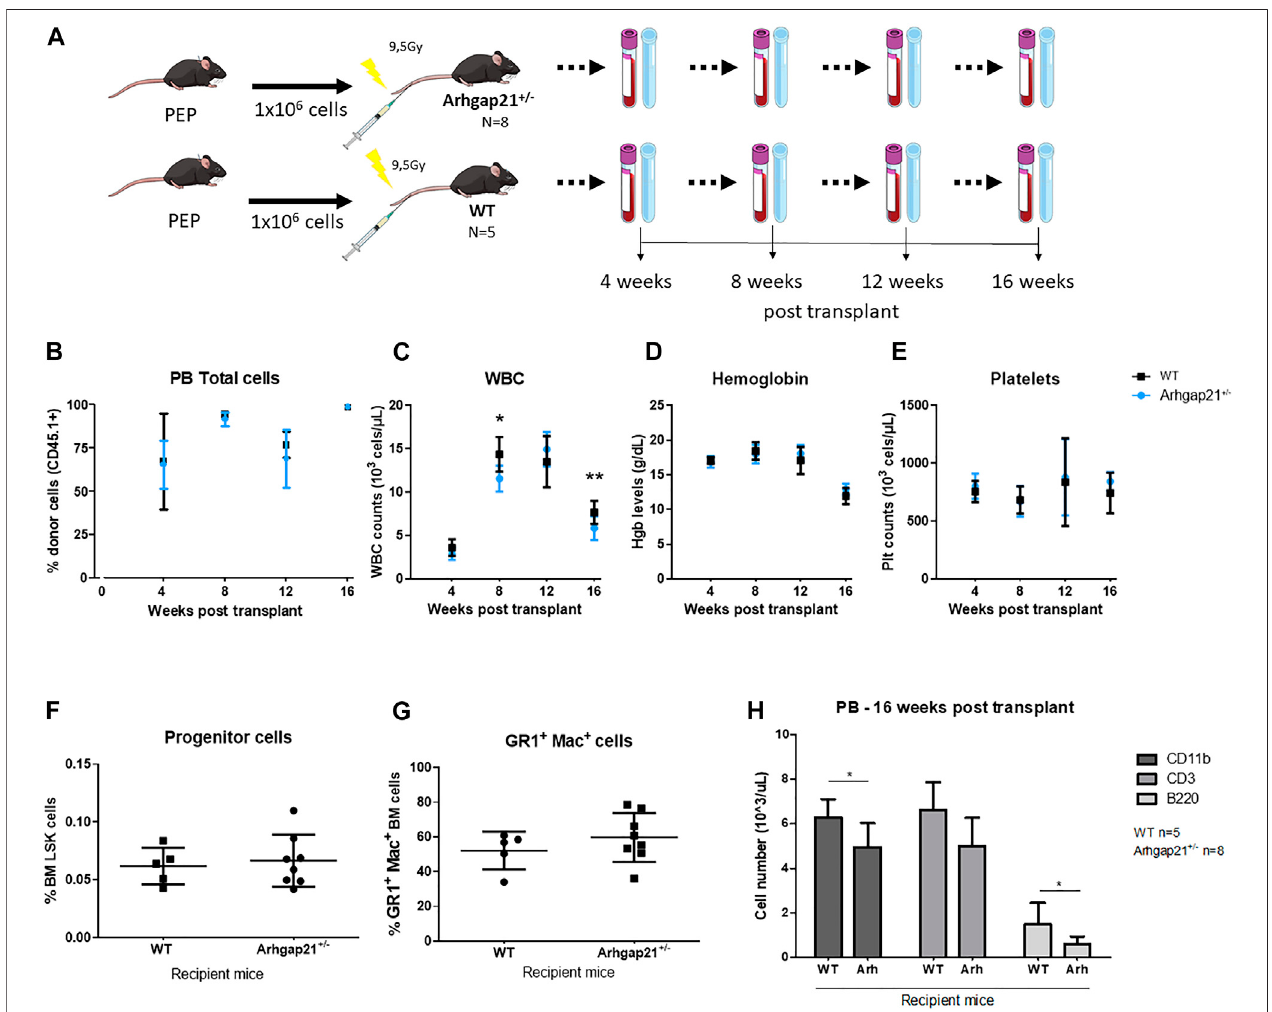
FIGURE 4 | Decreased WBC reconstitution in Arhgap21 +/ − recipients of bone marrow transplantation. (A) Schematic fi gure of 1 × 10 6 PEP BM cells transplanted into irradiated (9.5 Gy) Arhgap21 +/ − recipients ( N (cid:2) 8) and WT recipients ( N (cid:2) 5). Recipient mice were maintained for 16 weeks after transplantation and chimerism (CD45.1+), WBC count, hemoglobin levels (Hgb) and platelet count (Plt) were assessed every 4 weeks post-transplant. (B) Engraftment of PEP marrow cells CD45.1+ were similar in WT and Arhgap21 +/ − recipients. (C) WBC counts were decreased in Arhgap21 +/ − recipients compared with WT recipients at weeks 8 and 16 following the transplant. (D) Hemoglobin levels and (E) platelet counts did not differ between WT and Arhgap21 +/ − recipients. (F) Frequency of immature LSK and (G) GR1 + Mac + cellular populations were also similar between the two groups. (H) Absolute counts of CD11b+ and B220 + cells (but not CD3 + cells) were decreased in the PB of Arhgap21 +/ − recipients compared with WT recipients. Mean and standard error of the mean are shown in all graphs; 2-way Student ’ s t -test; * p < 0.05.